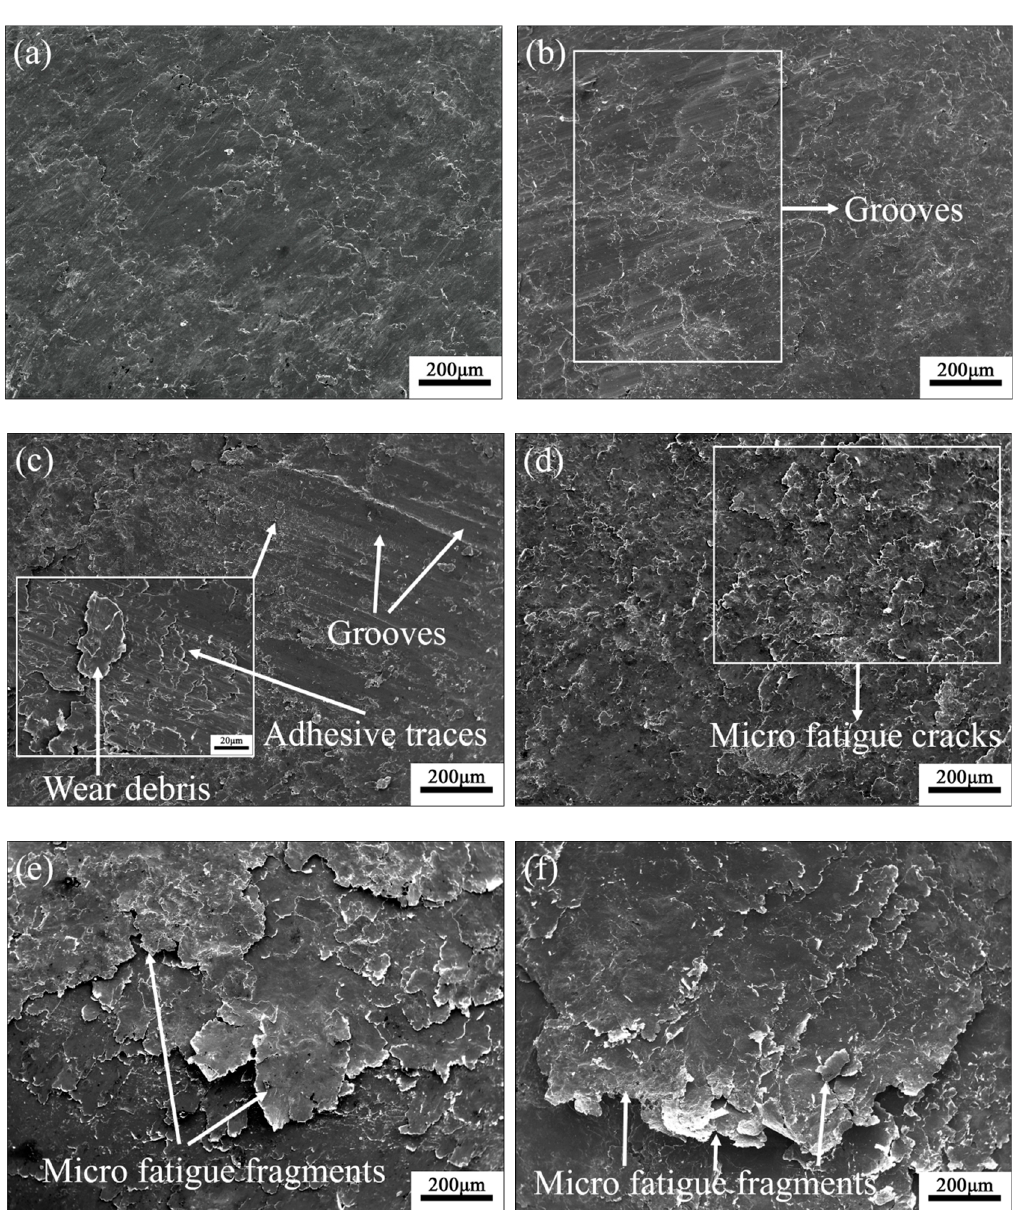
Figure 3. Surface morphologies of the steel tempered at 680 °C for different impact wear times, ( a ) 5 min; ( b ) 10 min; ( c ) 15 min; ( d ) 30 min; ( e ) 60 min; ( f ) 120 min.